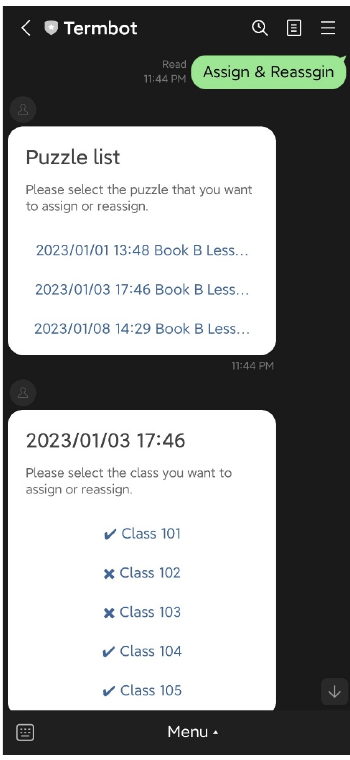
Figure 9. The function “Assign & Reassign”.